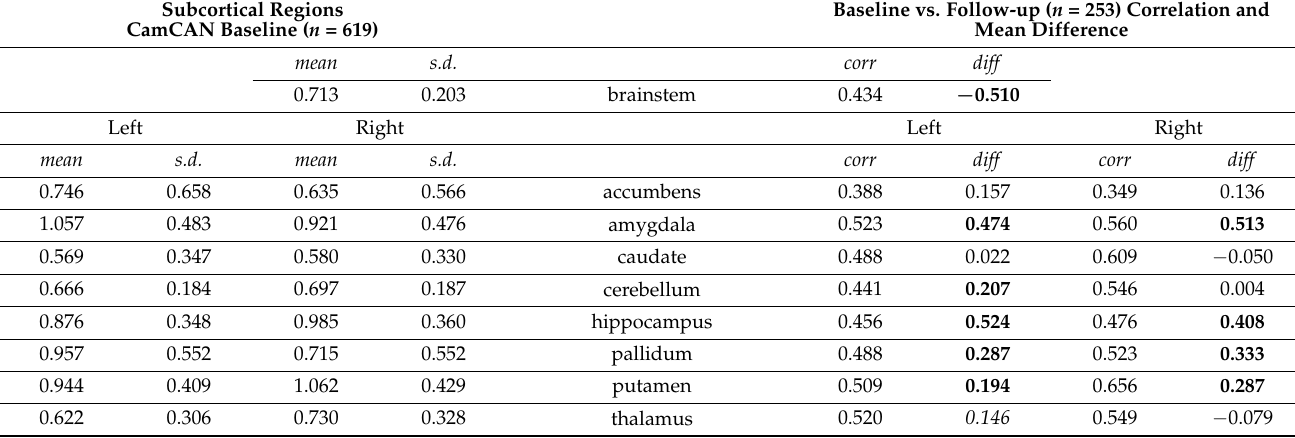
Left panel—Atlas. Table (right)—good test-retest reliability. As for Tables A1 and A3, Diff is the mean z-score difference: follow-up–baseline; mean interval is 16 months. Moderate significance (i.e., 0.03 > p > 0.002; − 3.0 < t < 3.0) is indicated with italics; high significance (i.e., p < 0.002; t ≥ 3.0) is indicated in